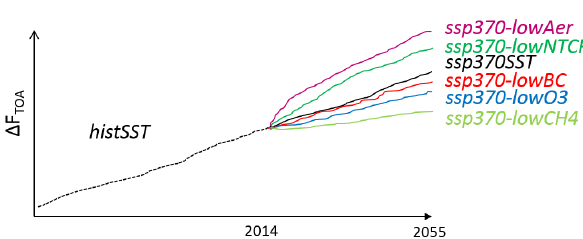
Figure 2. Schematic of future prescribed SST simulations based on the SSP3-7.0